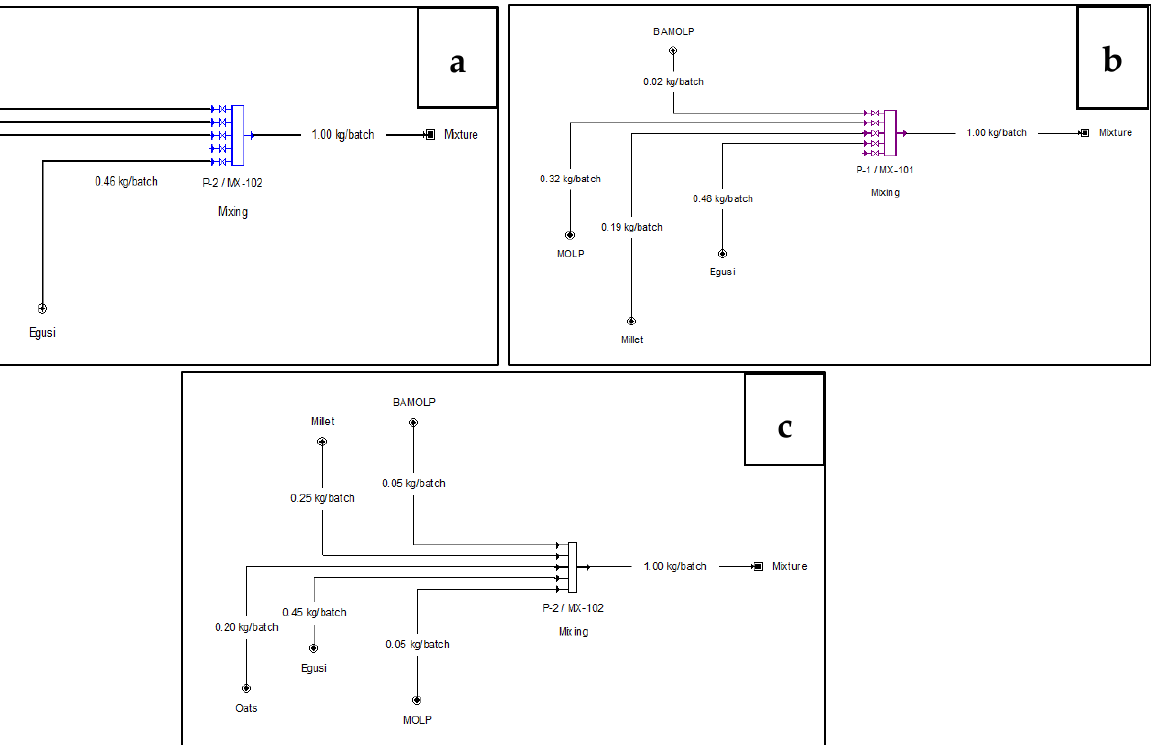
Table 2. Optimisation goal for Bambara groundnut and Moringa oleifera snack bar.